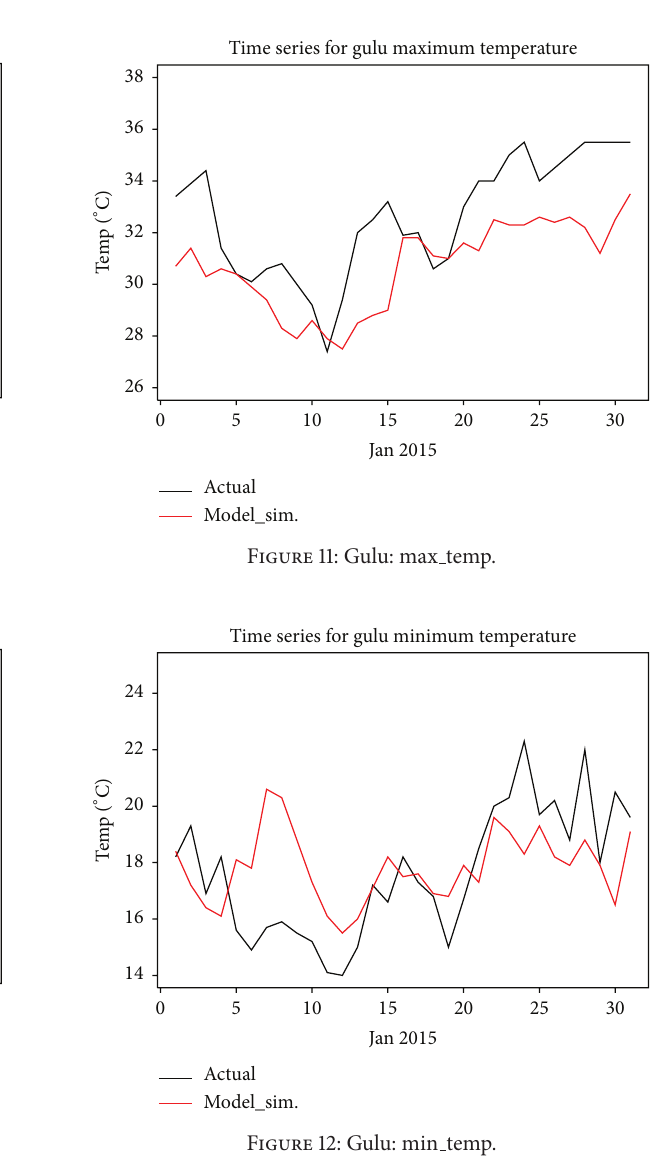
Figure 12: Gulu: min